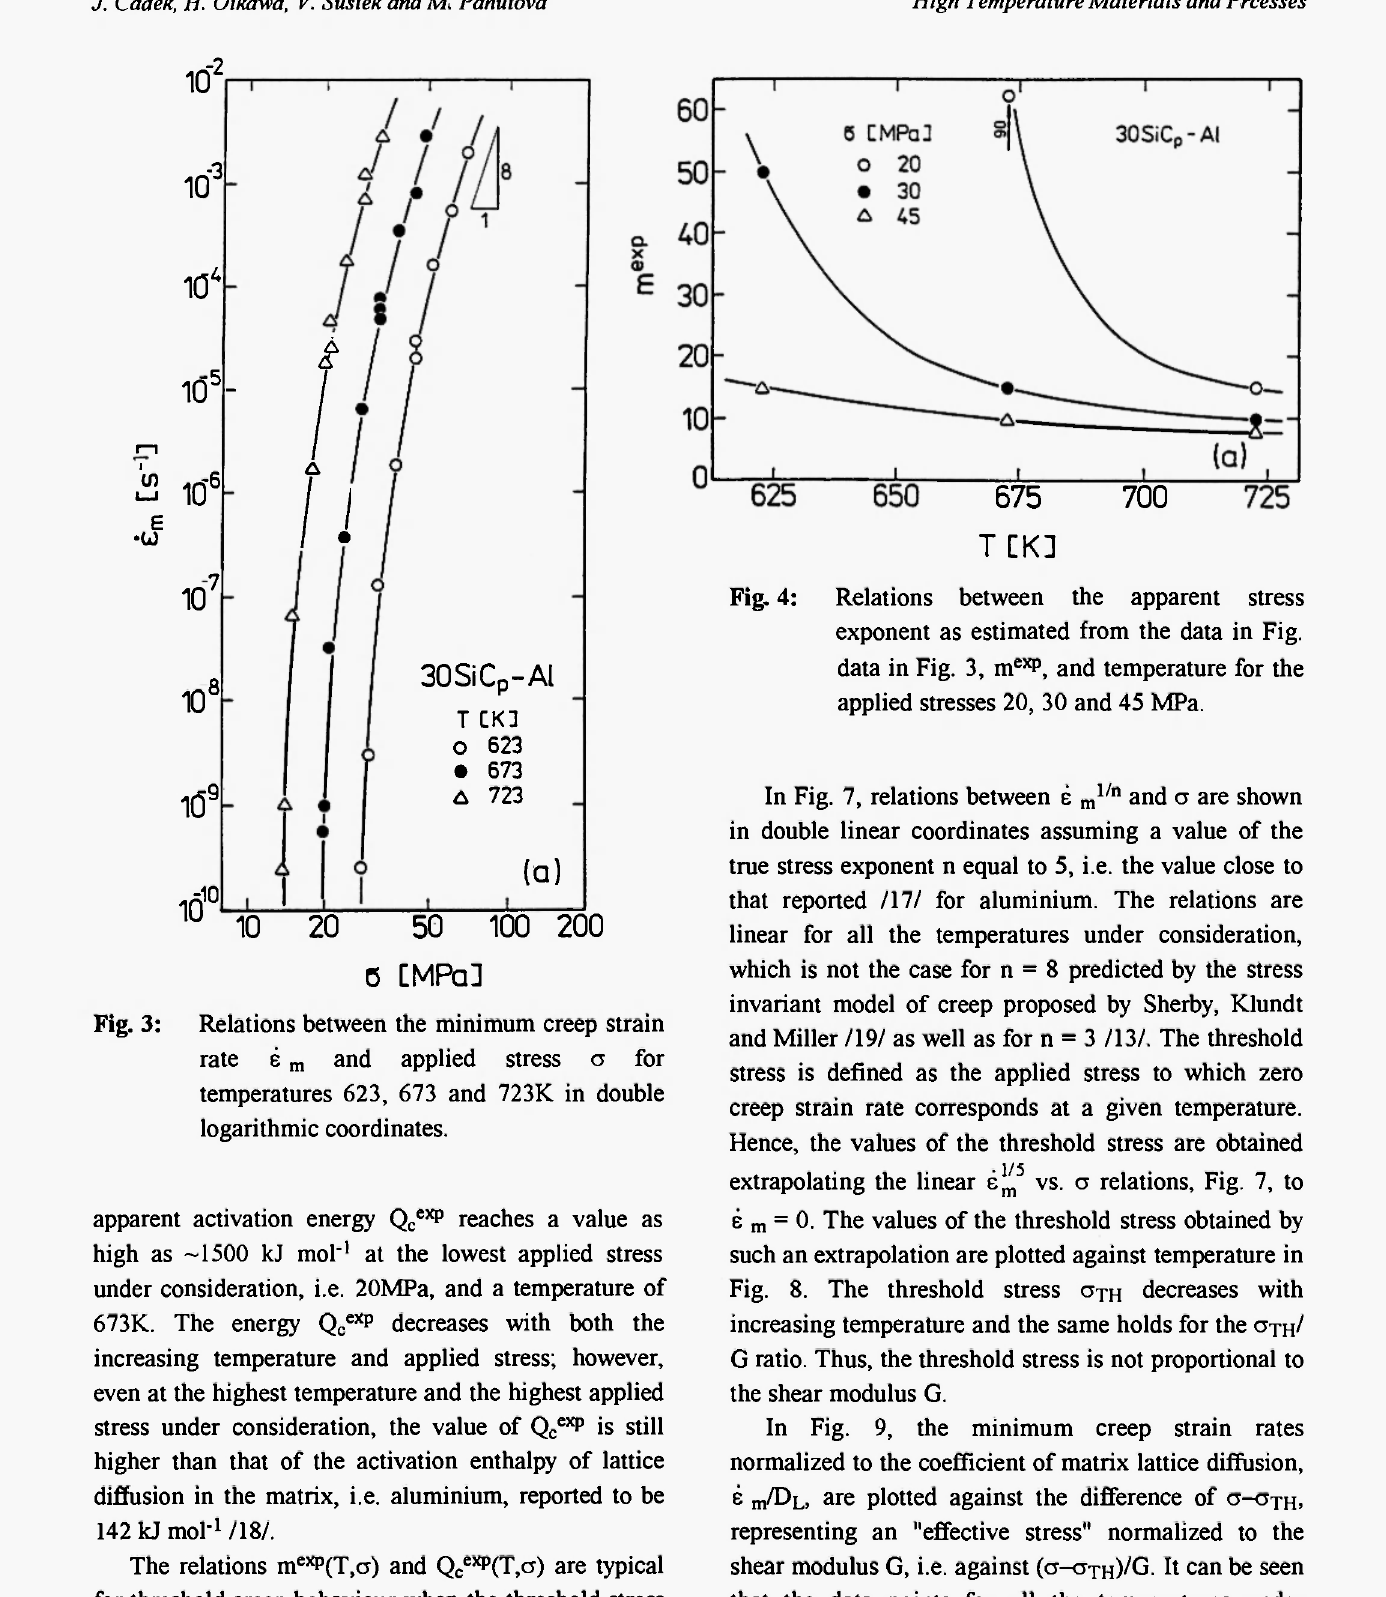
Fig. 8. The threshold stress σ increasing temperature and the same holds for the σ G ratio. Thus, the threshold stress is not proportional to the shear modulus G. In Fig. 9, the minimum creep strain rates normalized to the coefficient of matrix lattice diffusion, έ /D , are plotted against the difference of σ-σ m L shear modulus G, i.e. against (a-o that the data points for all the temperatures under